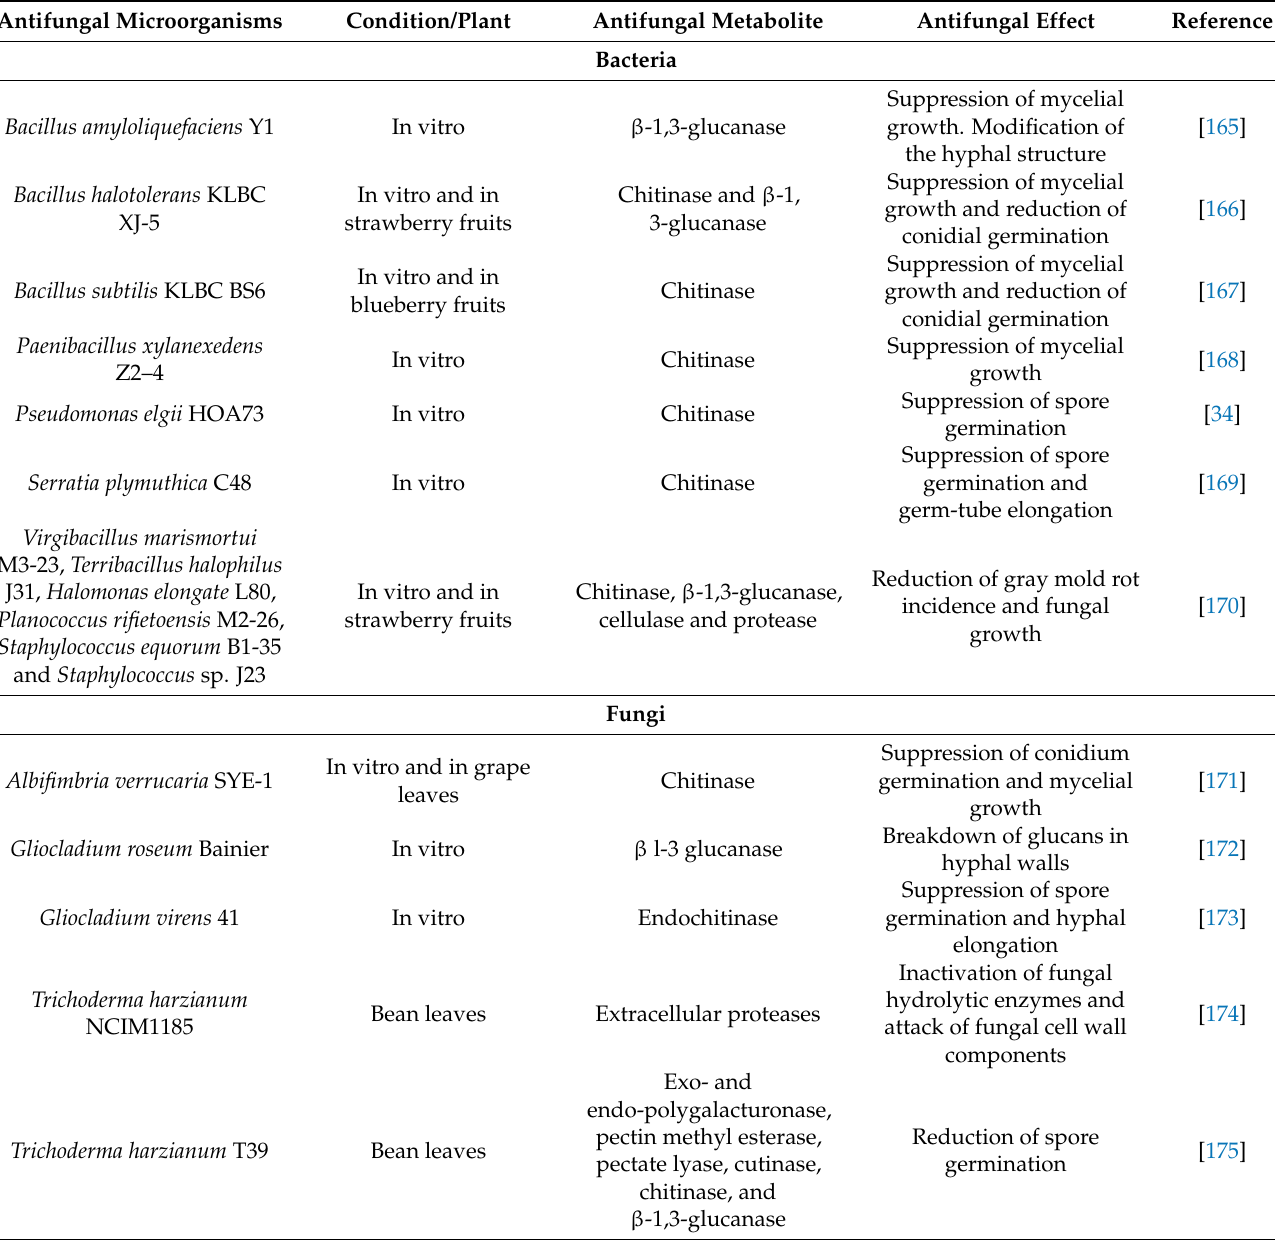
Table 3. Overview of literature reporting the inhibition of Botrytis cinerea through hydrolytic enzyme production. Antifungal